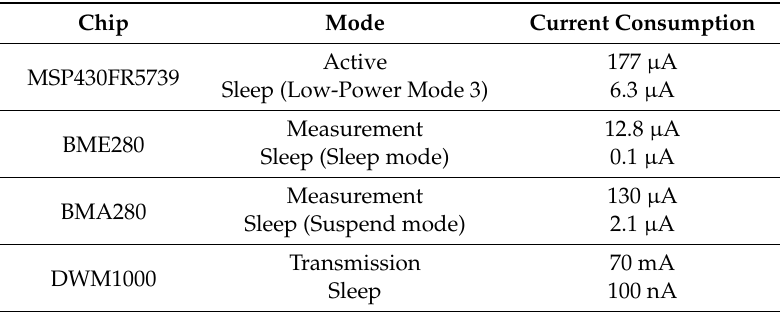
Table 1. Tag’s components current consumption.